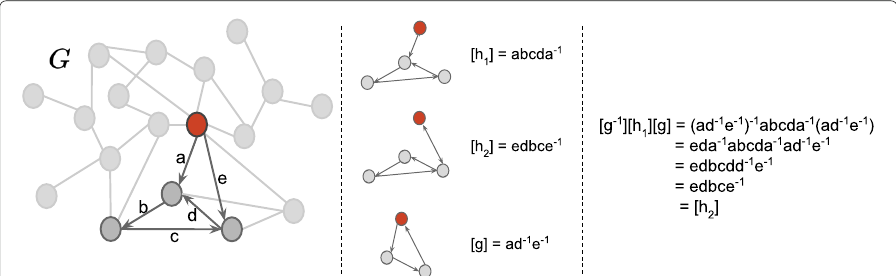
Fig. 2 Conjugate homotopy classes in a graph. Left: In an undirected graph G we label some directed edges a , b , c , d and e . We use the red node as basepoint to construct homotopy classes. Center: Three